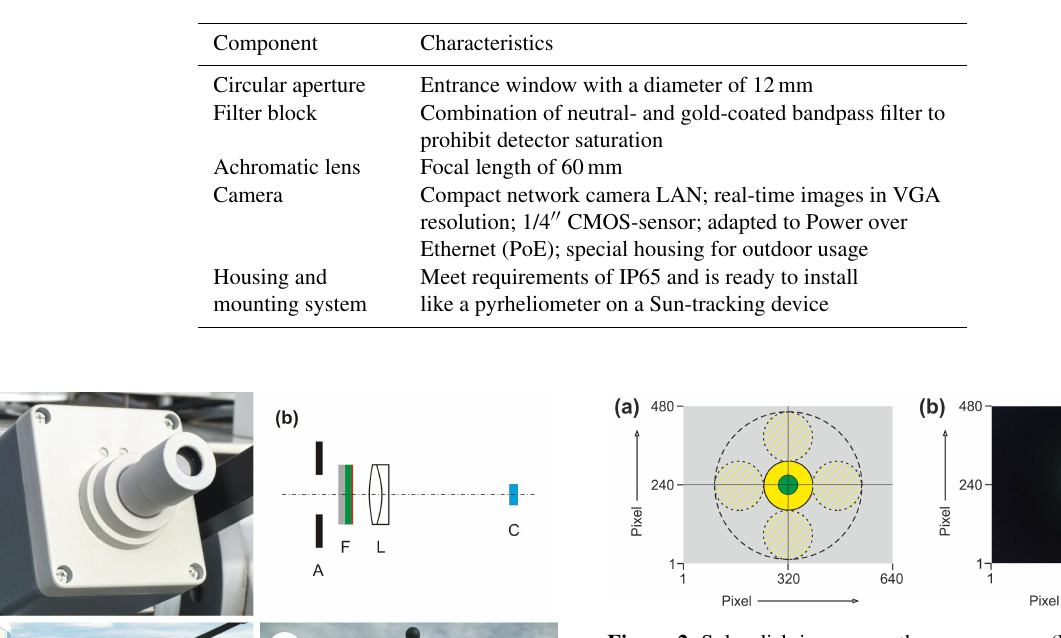
Figure 2. Solar disk images on the sensor array (VGA resolution) of the compact network camera of KSO-STREAMS. (a) Range of the detectable free movement of the positions of solar disk images within the detector array due to possible misalignment of the Sun- tracking device (the yellow area is the optimal position of the so- lar disk image, the green marked zone is the possible center of the solar disk image to be within BSRN requirements, and the yellow shaded area is the detectable misalignment of the Sun-tracking de- vice through KSO-STREAMS); (b) typical solar disk image under clear-sky